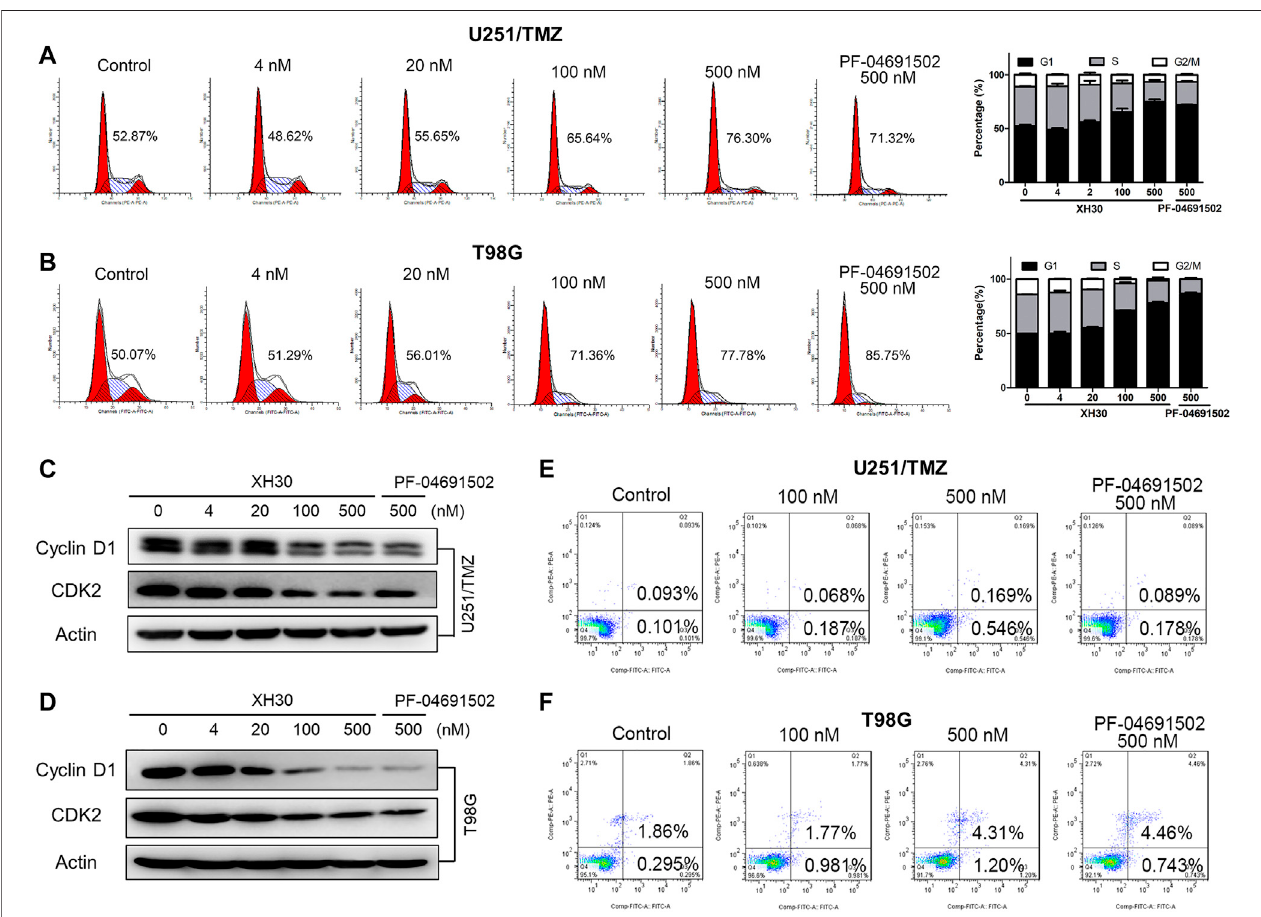
FIGURE3| XH30 inducedG1cell-cyclearrest inTMZ-resistant GBMcells. (A, B) XH30induced cellcycle arrestinTMZ-resistant U251/TMZ andT98Gcells inthe G1 phase. Exposure to various concentrations of XH30 at indicated concentrations (4, 20, 100, and 500 nM) or the control, PF-04691502 (500 nM), for 24 h. The cells werestainedwithpropidiumiodide(PI)for fl owcytometryanalysis, n (cid:1) 3. (C,D) XH30downregulatedmarkersoftheG1phaseofthecellcycle.Theproteinlevelsofcyclin D1andCDK2weredetected via immunoblottinginbothU251/TMZandT98GcellsexposedtoXH30for24 h. (E,F) TheeffectofXH30onapoptosisinbothU251/ TMZ and T98G cells exposed to XH30 for 48